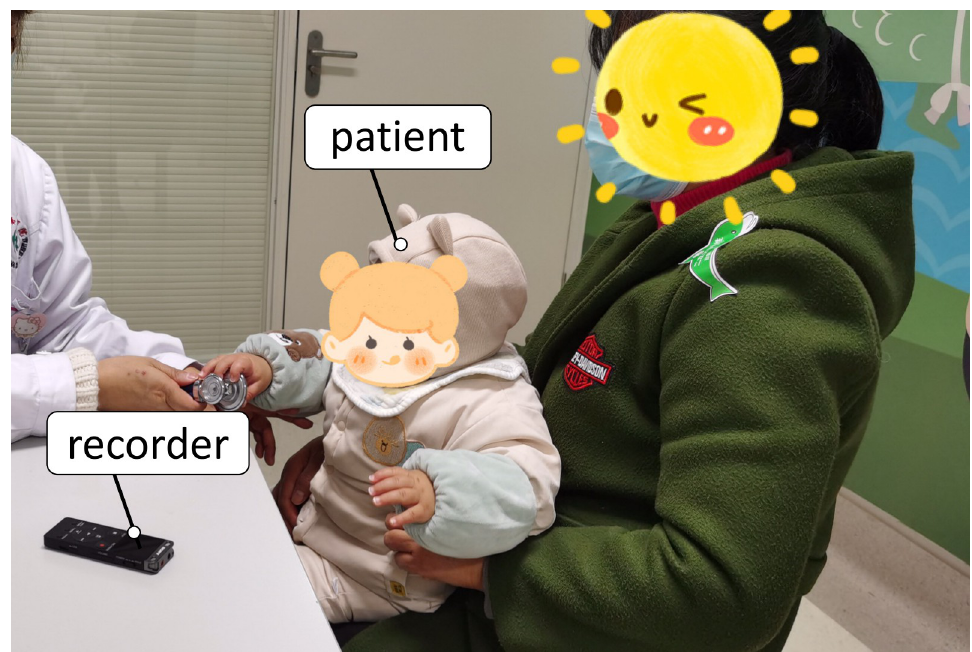
Fig 3. Recording setup in the hospital. We collected patient audios in a pediatrics consulting room of the West China Second University Hospital, Sichuan University, Chengdu,